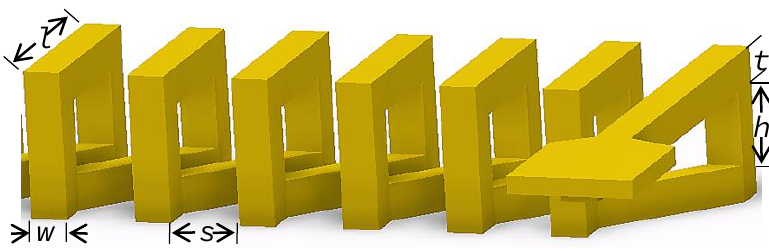
Figure 2. The geometric structure parameters diagram of the micro-inductor coil.